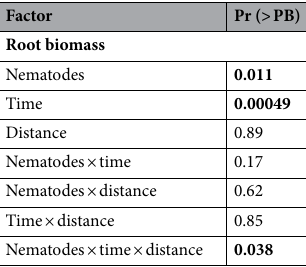
Table 3. Effect of nematode inoculation, distance from the focal plant, and sample harvest time for leachate collection on receivers’ root biomass. p values were calculated based on parametric bootstrapping. P < 0.05 is highlighted in